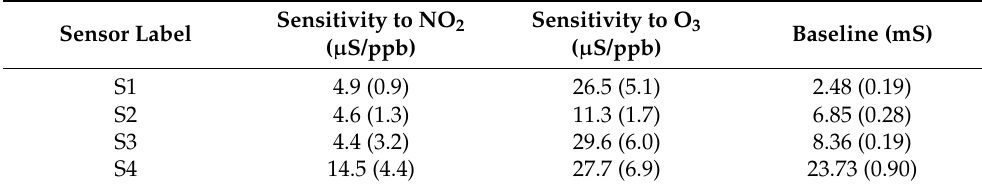
Table 2. Sensitivities of the sensors to the individual gases at 30 ppb concentration (average over all cycles, uncertainties indicated in the brackets as double standard